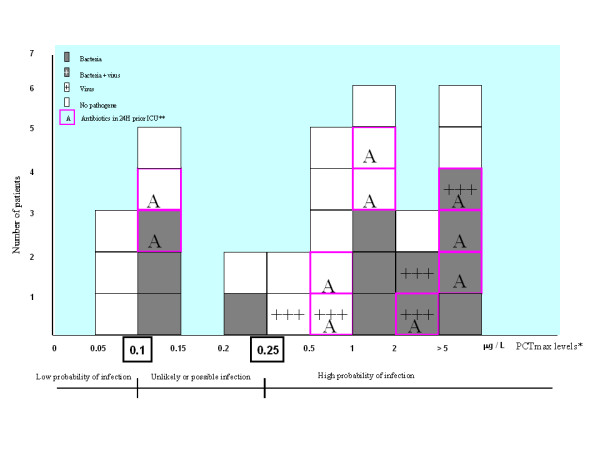
Distribution of the highest procalcitonin level measurements (PCTmax) and microorganism findings in chronic obstructive pulmonary disease (COPD) patients with pneumonia. Also shown is the probability of bacterial infection according to procalcitonin (PCT) levels, as previously reported by Christ-Crain (11). * Procalcitonin (PCT) levels were not assessed in 2 patients. ** One patient receiving antibiotic in 24 h prior ICU was not assessed for PCT levels.